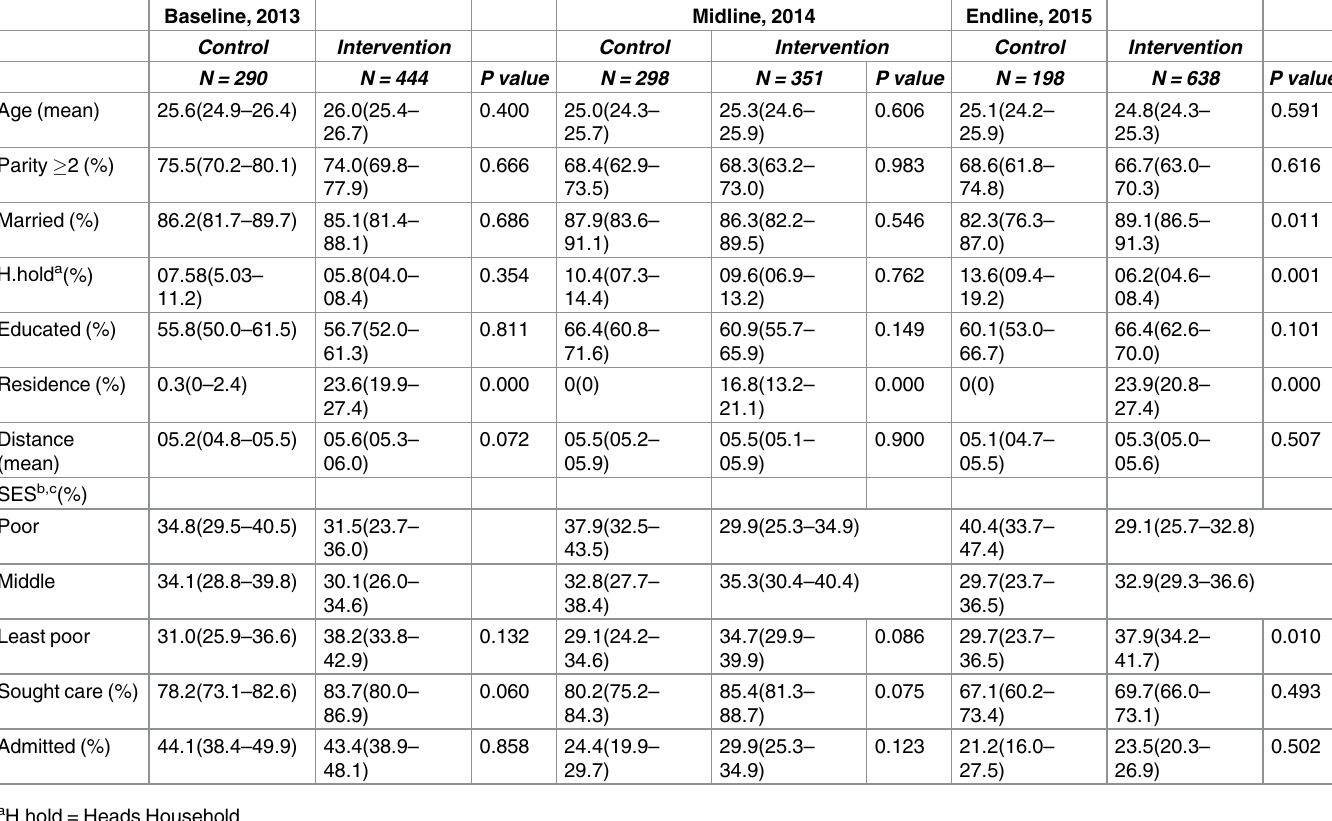
Table 2. Socio-demographic characteristics and care seeking for women with self-reported complications, by group and survey year.